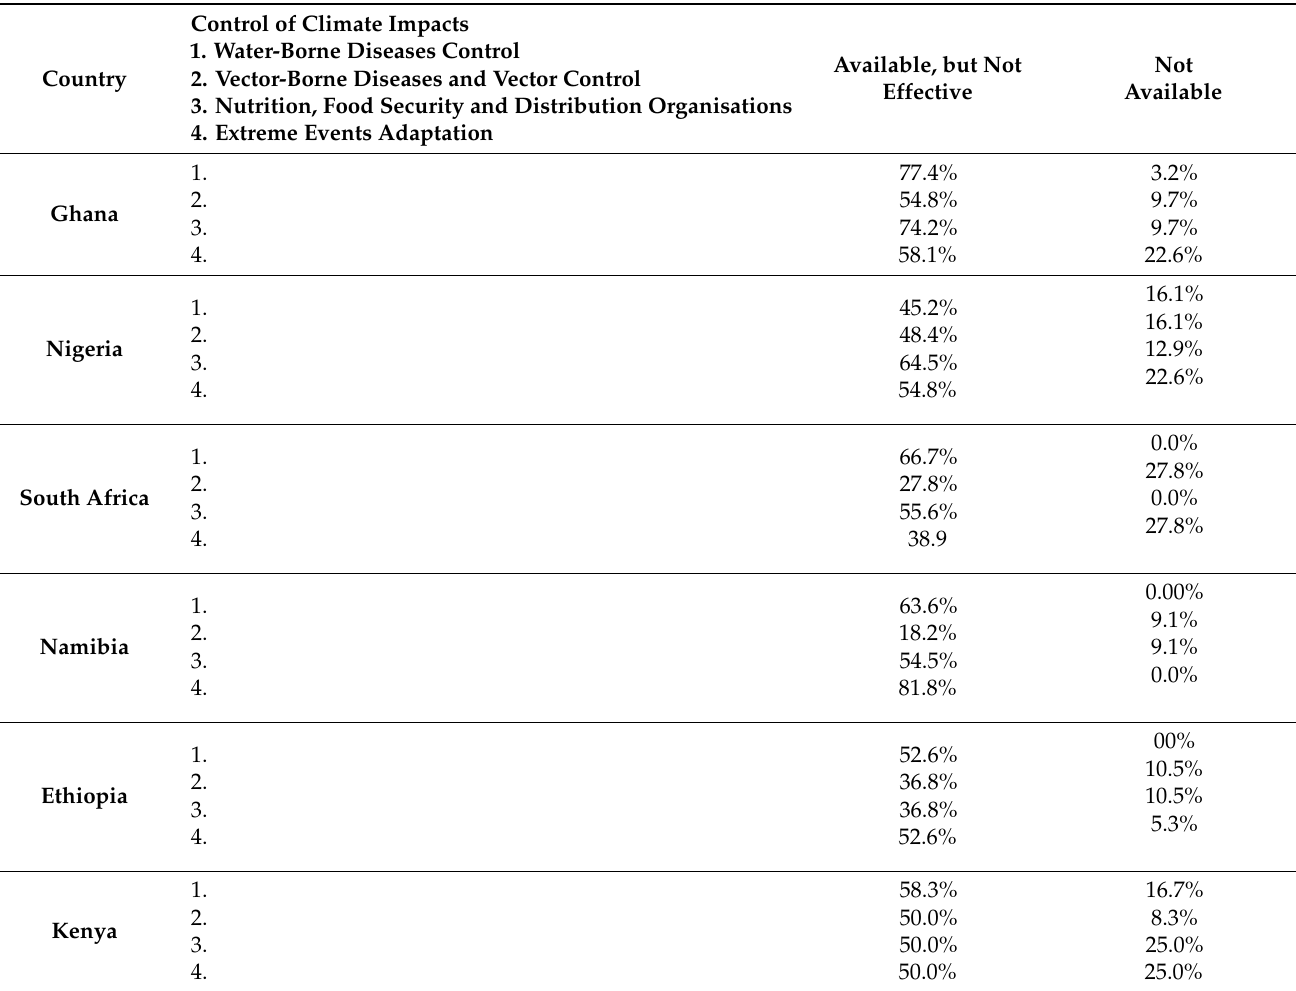
Table 7. Sampled countries’ intervention programs to deal with the health impacts of climate change as perceived by